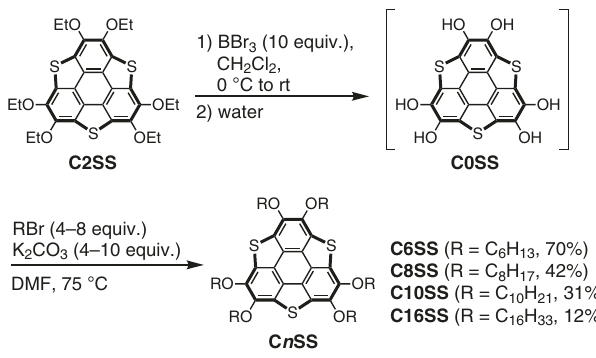
Fig. 3 Synthesis of the targeted C n SS derivatives ( n = 6, 8, 10, or 16).